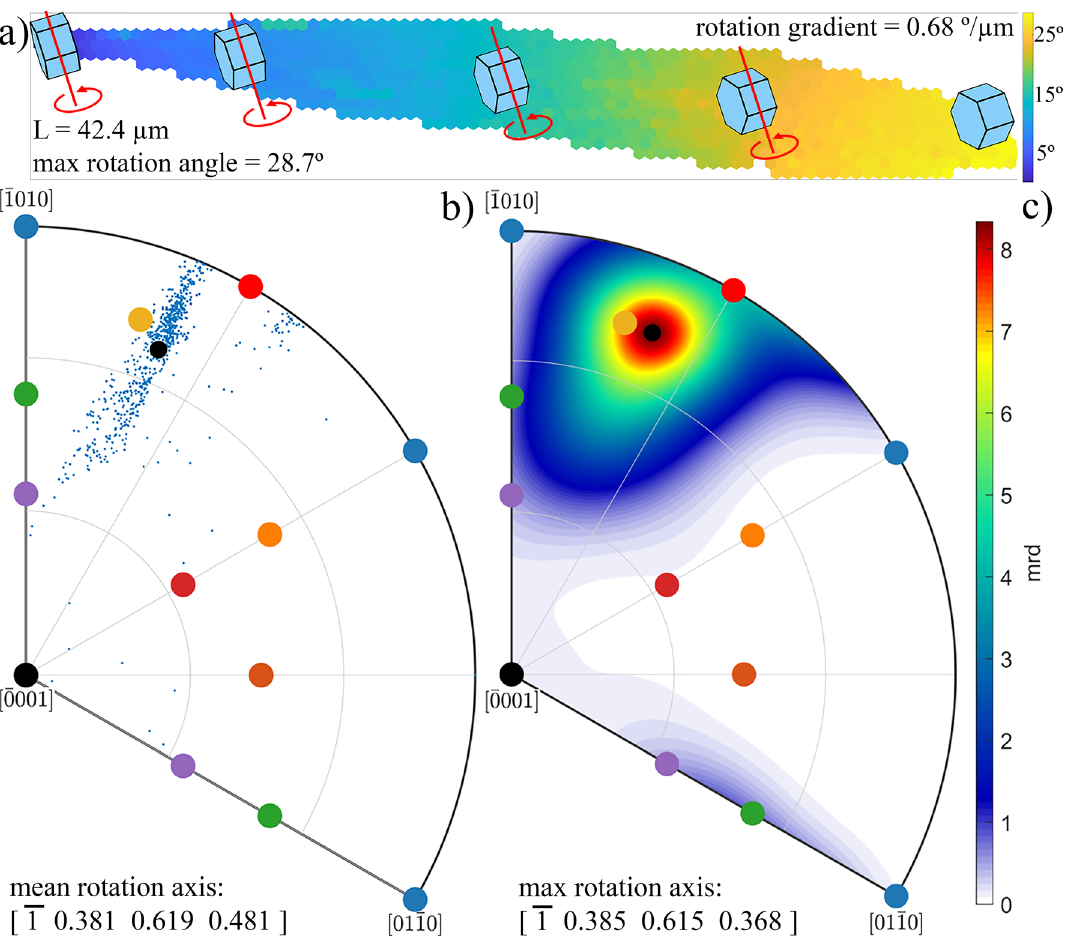
Figure 2. Crystal misorientation analysis of an individual fiber; ( a ) misorientation angle map of one horizontal fiber from the right spherulite on Fig. 1b. Color denotes the misorientation angle, between a local point and the leftmost fiber point (close to spherulite nucleation orientation). Local lattice orientation is shown in a few points, together with rotation axis and direction; ( b ) IPF of the rotation axis directions observed between the most left point and all other points in the fiber. The mean rotation axis direction is shown by a small black circle; ( c ) IPF of the calculated rotation axis distribution. The distribution maximum is shown by a small black circle; rotation axes of all common slip systems from Fig. S1c and Table S1 from “SI” are also marked in both